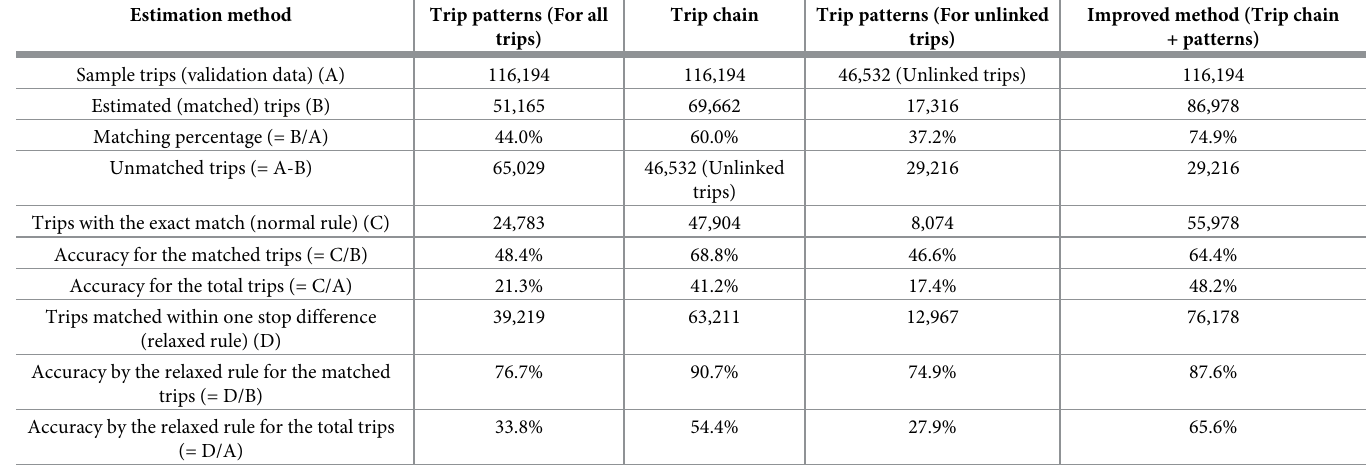
Table 2. Comparison of the estimation results by the trip chain method and improved